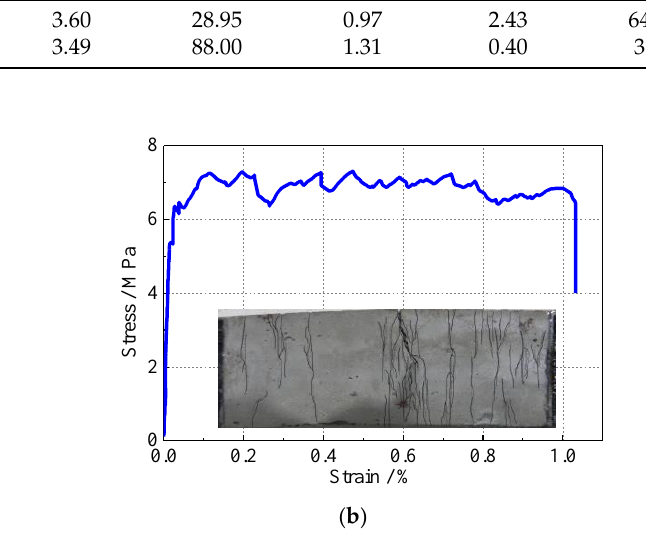
Figure 1. Uniaxial tensile tests: ( a ) test setup; ( b ) stress – strain curves and crack pattern.